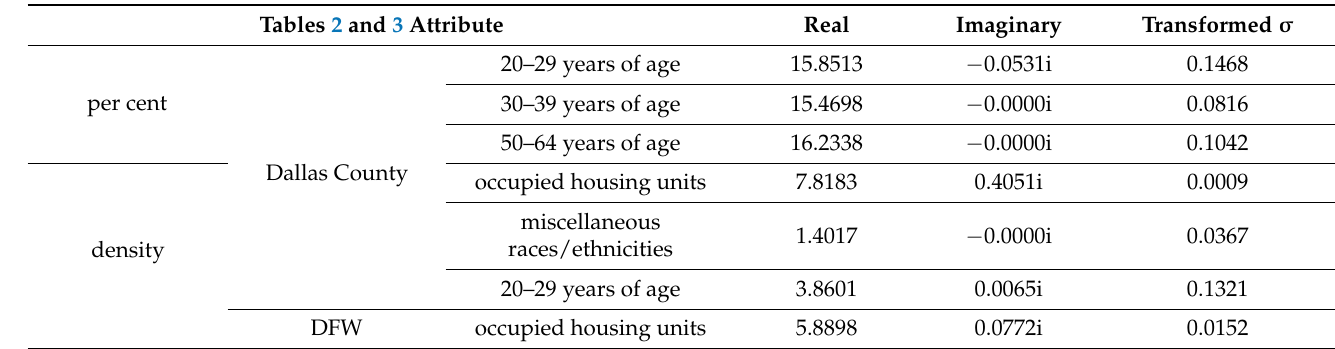
Table 7. Complex solutions to Equations (3) and (4) for specimen attribute